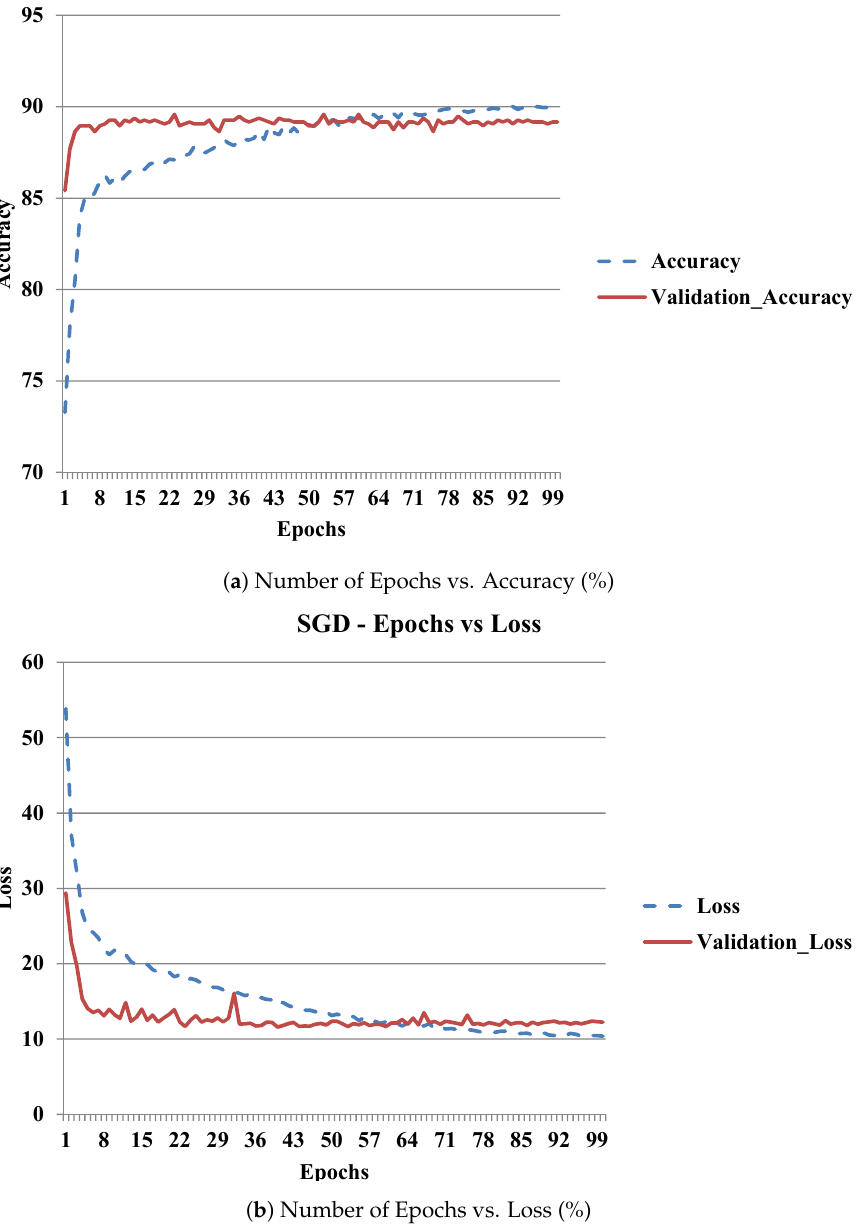
Figure 8. Accuracy and loss graph on training and validation data of SGD